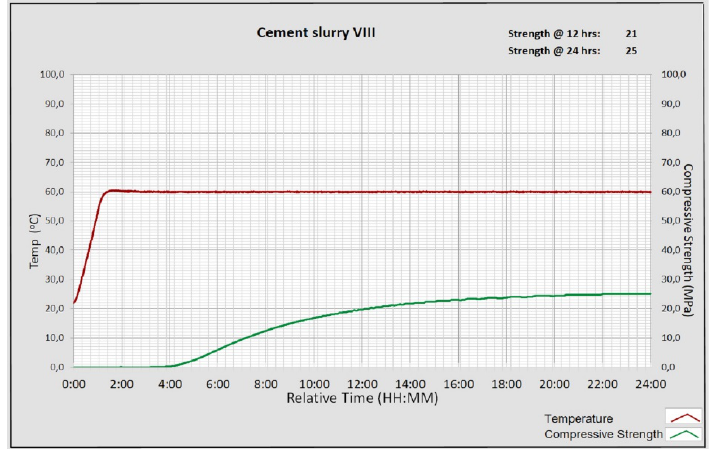
Figure 6. An increase in the early mechanical strength of sample VIII. Energies 2020 , 13 , x FOR PEER REVIEW